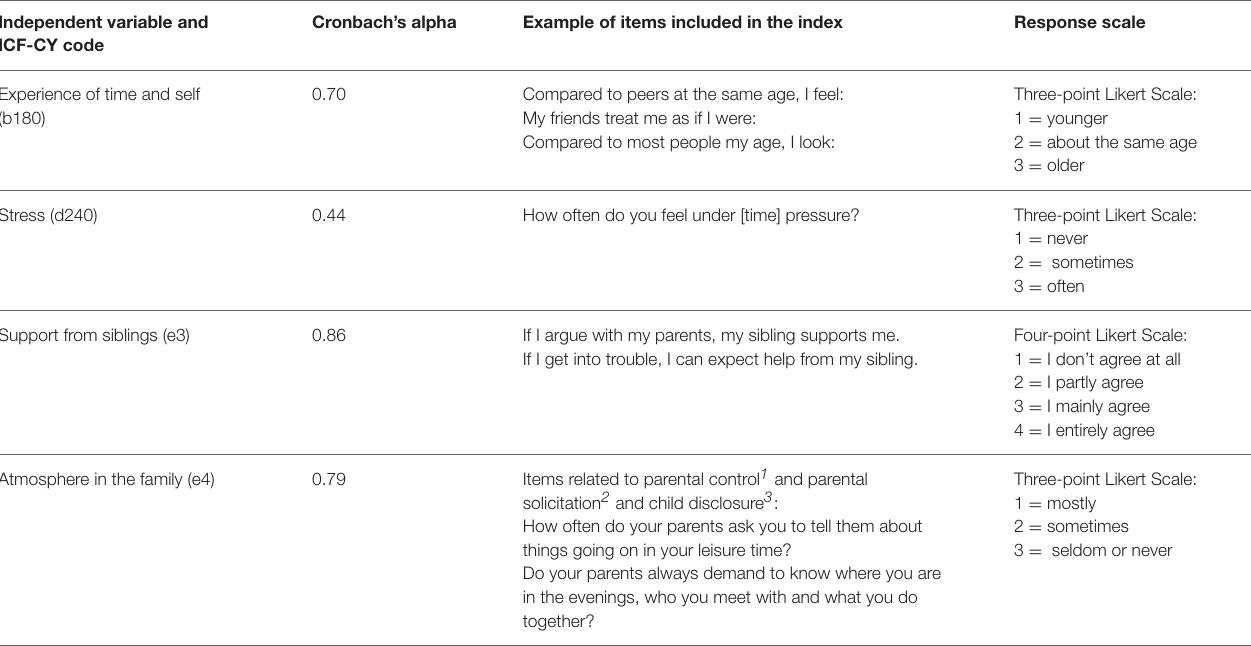
TABLE 2 | Overview of items in the independent